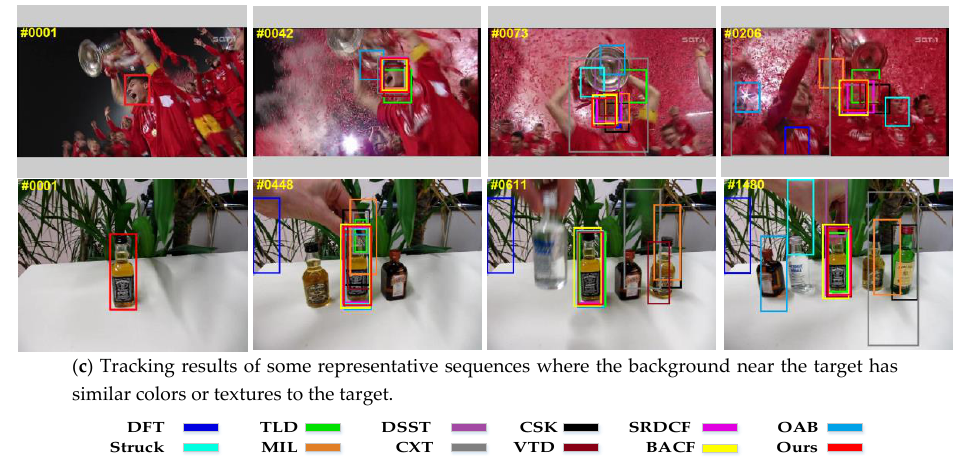
Figure 3. Tracking results of the proposed method and 10 state-of-the-art tracking algorithms for some representative sequences, including occlusion, motion blur, and background clutter.